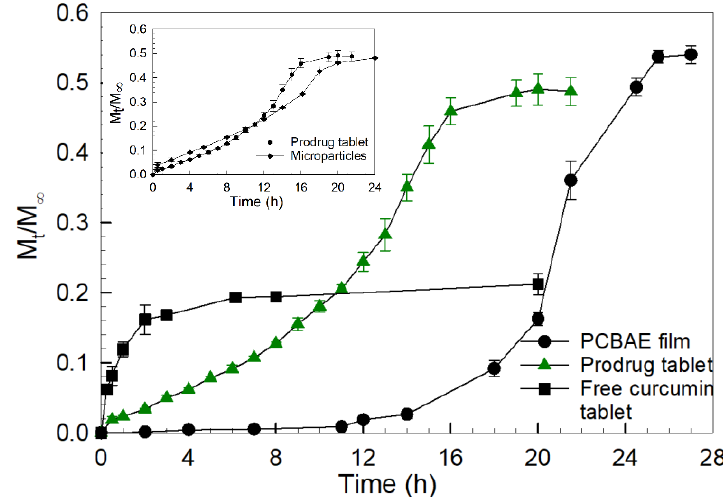
Figure 2. Curcumin release profiles for 90:10 CMA:PEG400DA PCBAE hydrogel film and tablets containing PCBAE microparticles (i.e., prodrug tablet) and free curcumin powder, respectively, in phosphate buffered saline (PBS) with 0.1 % SDS at 37 ◦ C, using USP apparatus II and analysis using the UV–Vis method. Inset plot shows curcumin release for prodrug tablet vs 90:10 CMA:PEG400DA as prepared microparticles without excipients.